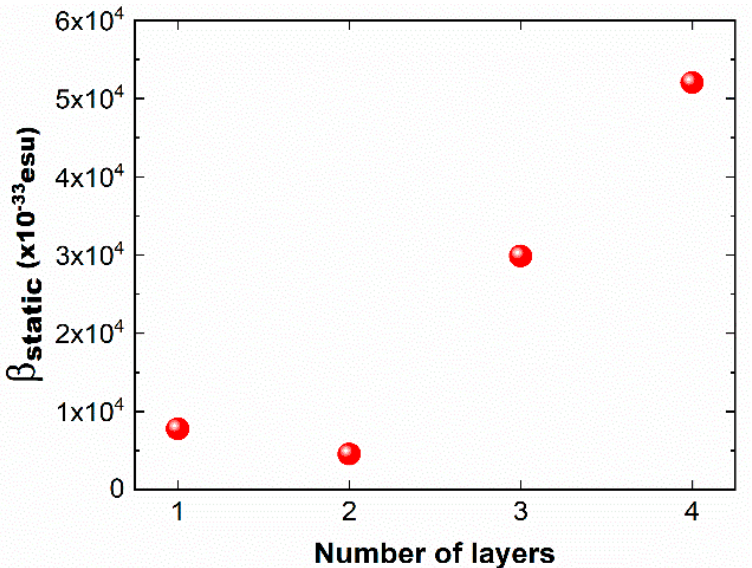
Figure 5. The first dipole hyperpolarizability (| β static |) for the monolayer, bilayer, trilayer, and quad-layer of borophene nanoflake.